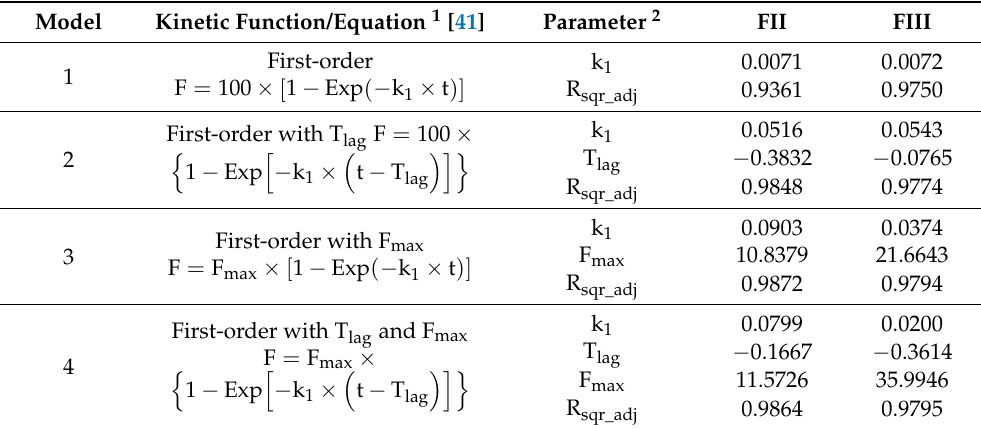
Table 3. The kinetic parameters of release profiles fitted with first-order kinetic equations.